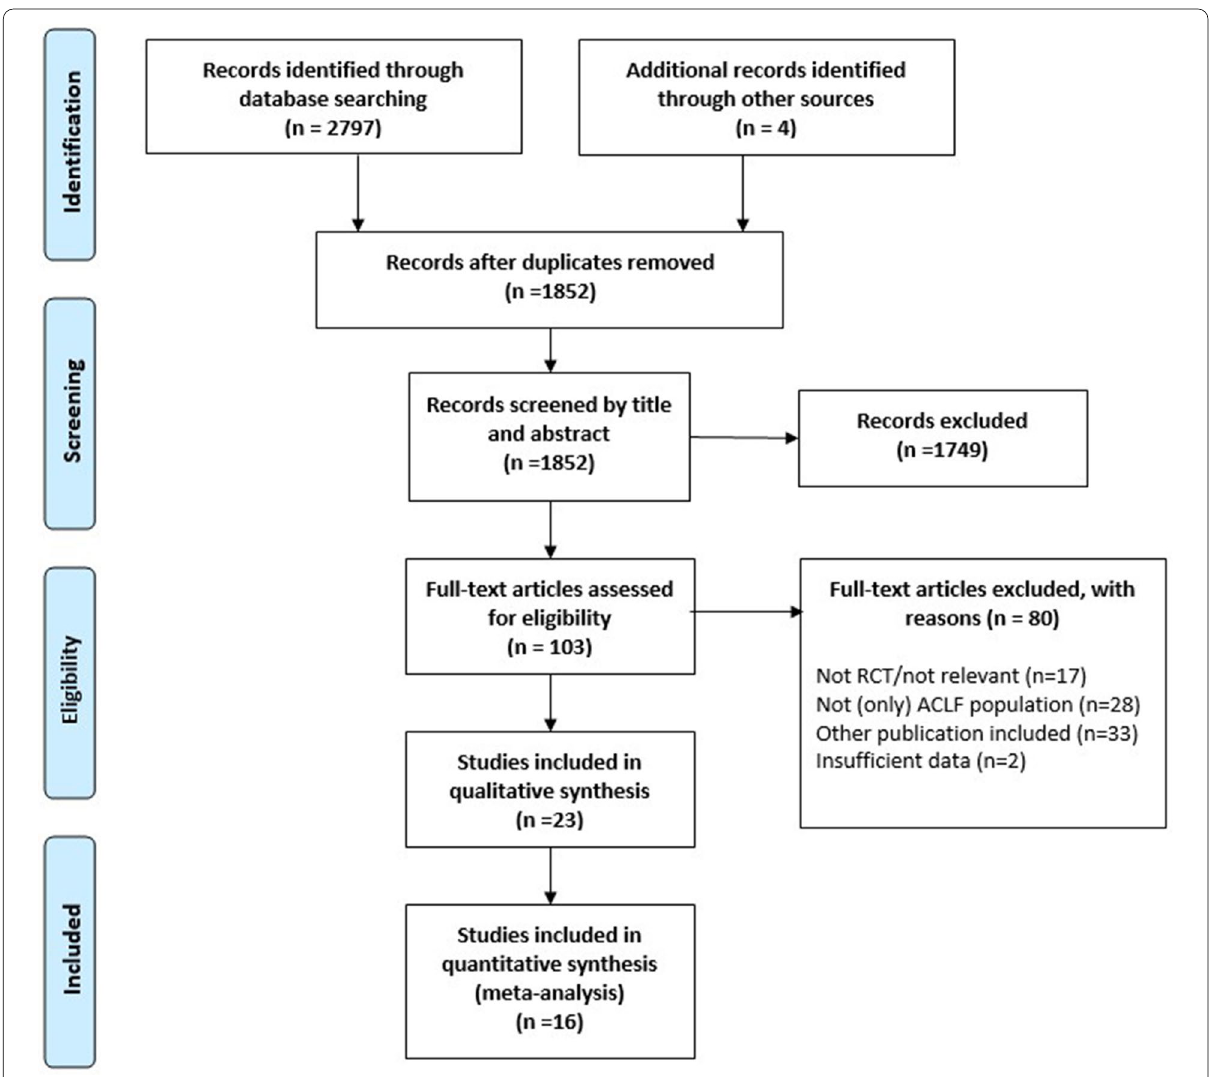
Fig. 1 Flowchart of study selection according to the PRISMA